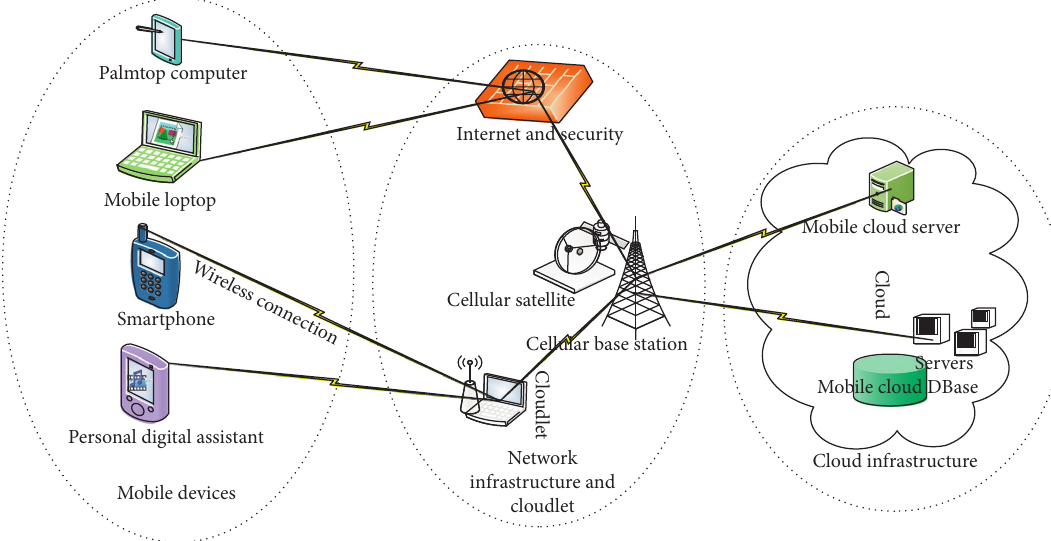
Figure 1: MCC system